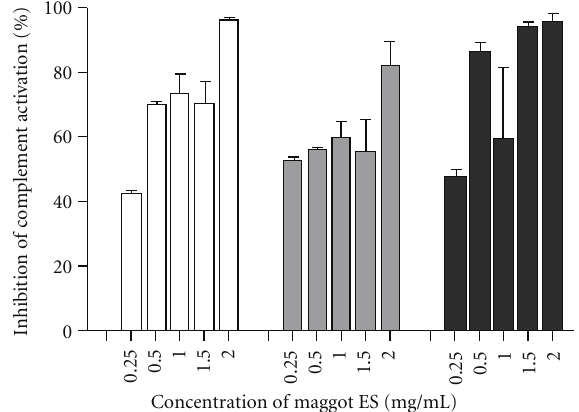
Figure 2: Dose-dependent e ff ect of fresh collected maggot ES on activation of the classical pathway (white bars), the alternative pathway (grey bars), and the lectin pathway (black bars) in normal human sera. The complement activation in four di ff erent sera was determined with the enzyme immunoassays from Wieslab (EuroDiagnostica BV, Arnhem, The Netherlands) according to manufacturer’s instructions. The percentages inhibition was calcu- lated using the values in the sera without maggot ES as 0%. The results are means and SD of four independent